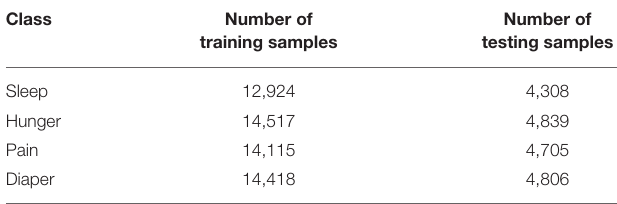
TABLE 7 | Comparing the merits and demerits of the top CNN variants. TABLE 8 | Number of testing samples for each class.